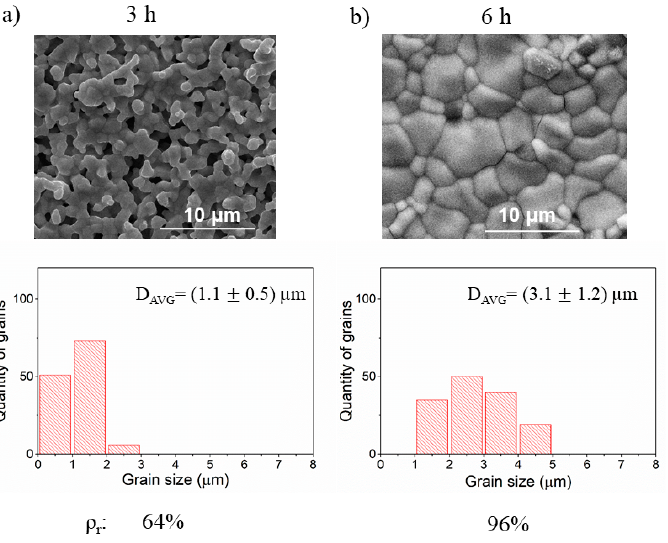
Figure 5. The SEM images of the BLCF pellets obtained during a different time of the reactants milling. Underneath each micrograph and individual grain size distribution with corresponding relative density value ( ρ r ) is shown. ( a , b ).